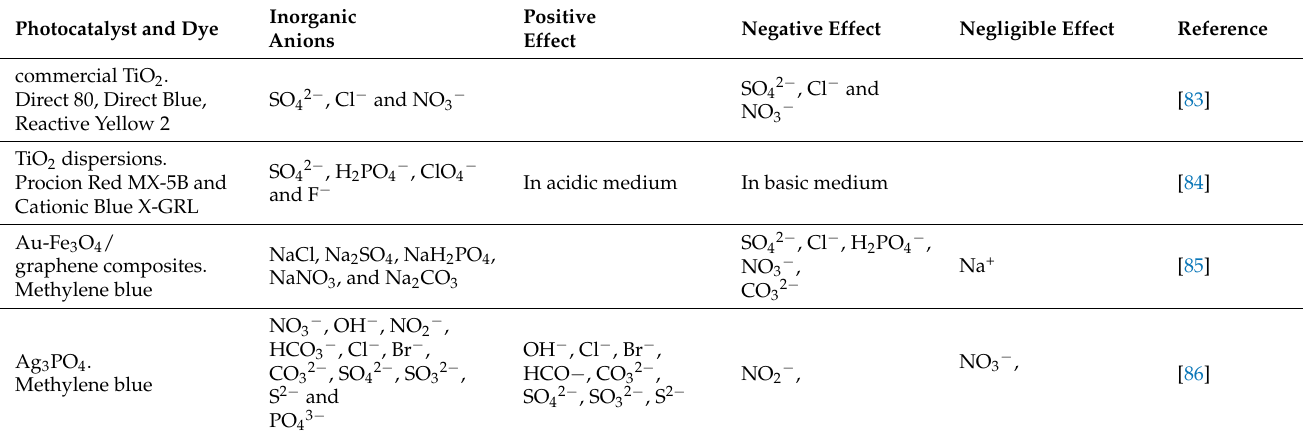
Table 2. Effect of inorganic anions present in TW on photodegradation of